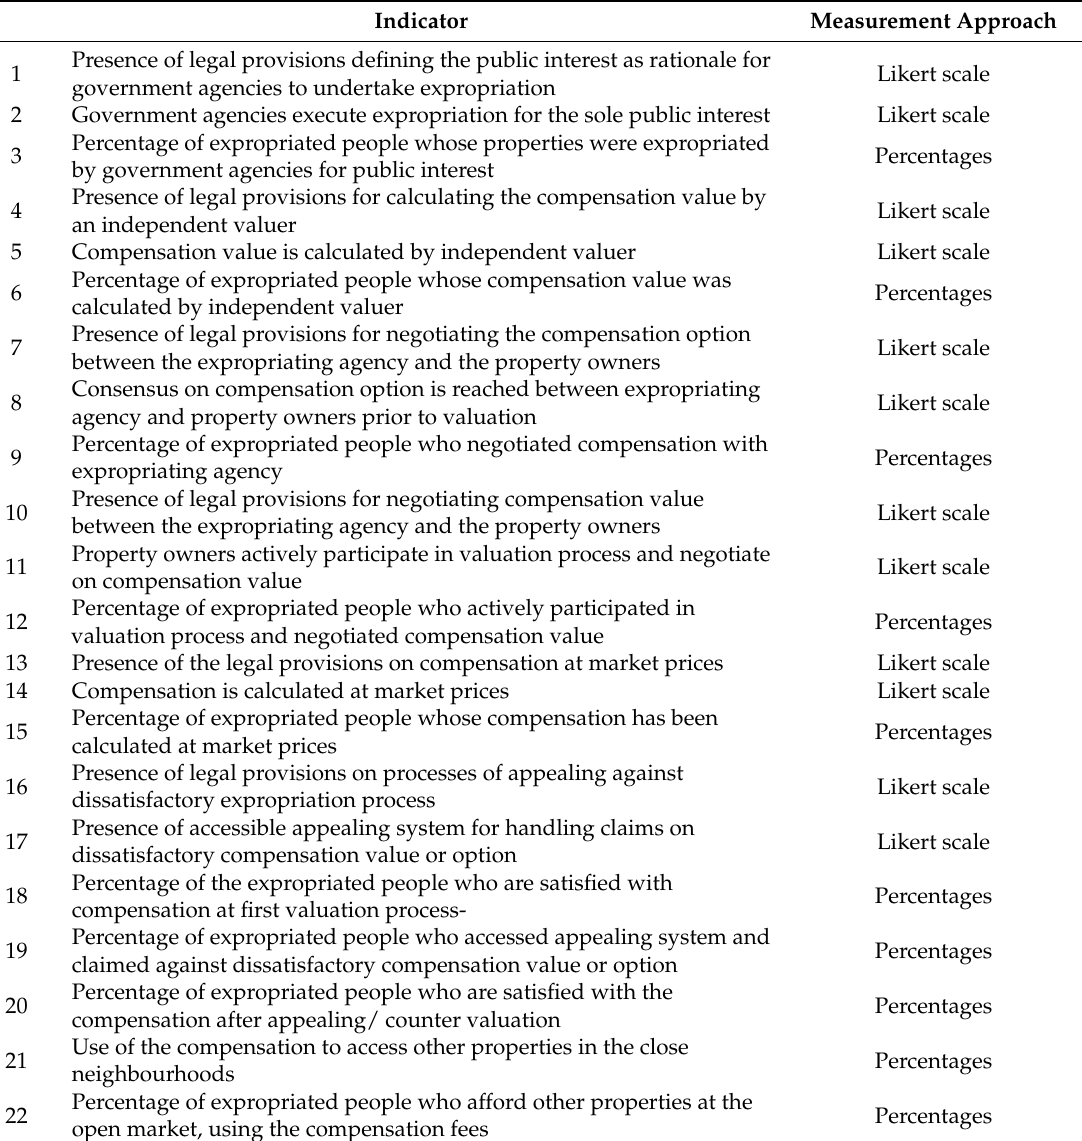
Table A1. Indicators for evaluating spatial justice trends alongside the expropriation in Kigali city. Indicator Measurement